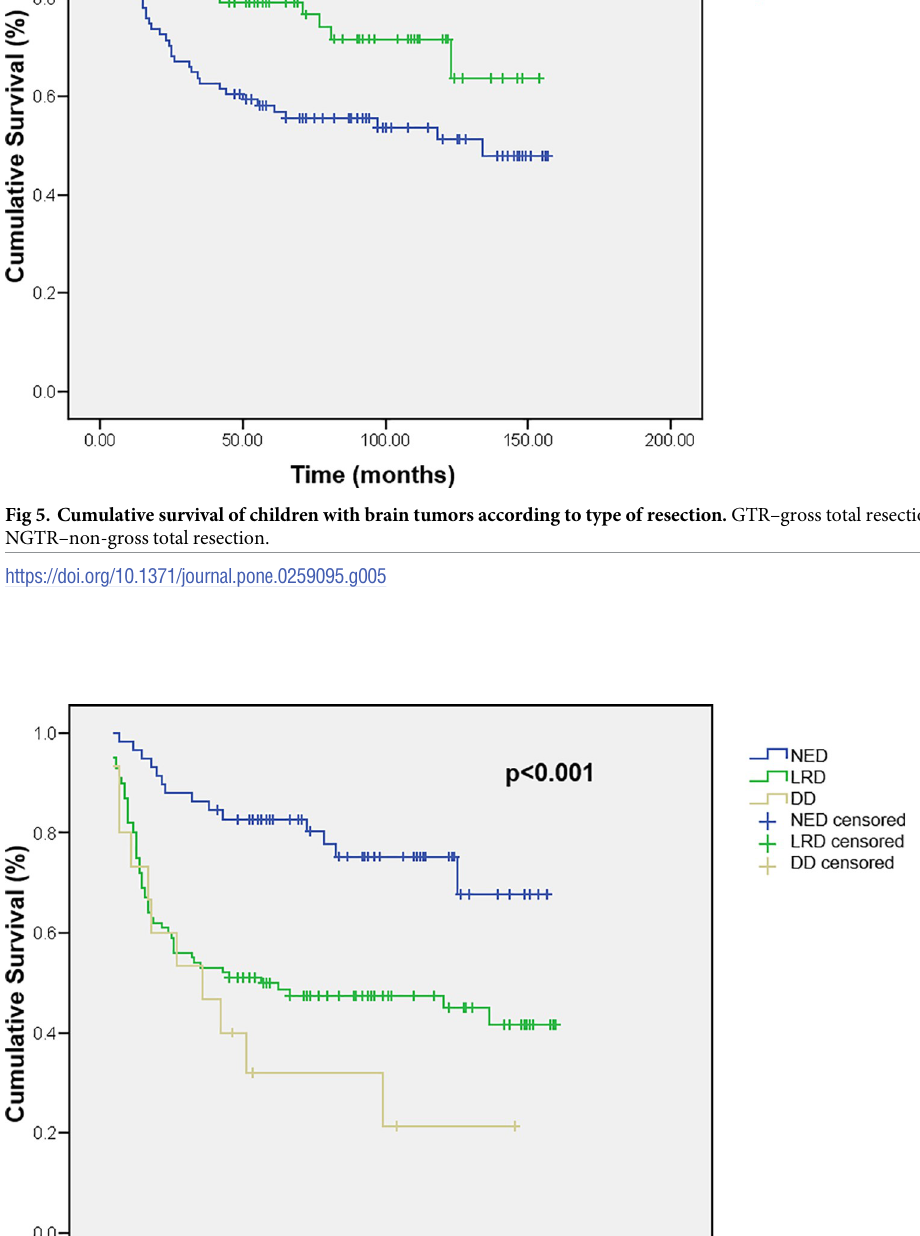
PLOS ONE | https://doi.org/10.1371/journal.pone.0259095 October 26,